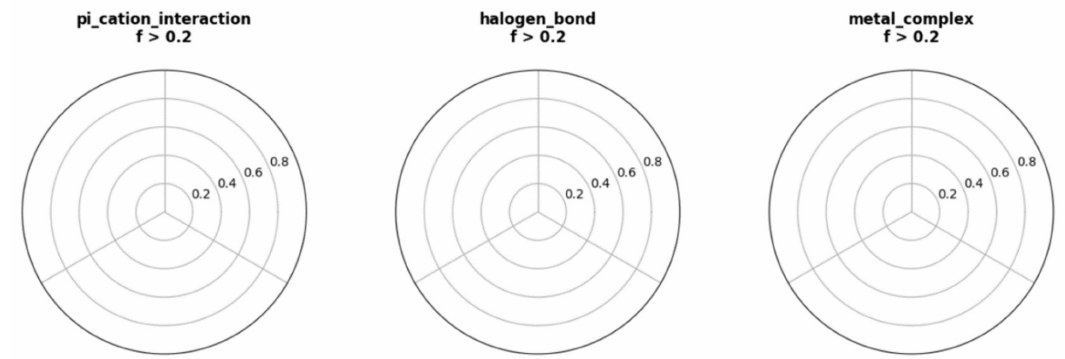
Figure 1. Interactive radar distribution map results of a ligand (UNK) bind to A2AR. We were able to see the changes of interactions with respect to simulation time in Figure 2, which is useful to assess the stabilities of interactions. Here different colors indicate different types of interaction. The hydrogen bond formed between D134 and ligand (yellow) is very stable, as it is formed during the whole simulation. The hydrophobic interaction between F328 and ligand does not exist in the crystal structure, but can be formed in the simulation, which could be due to the rearrangements of ligands and residues.